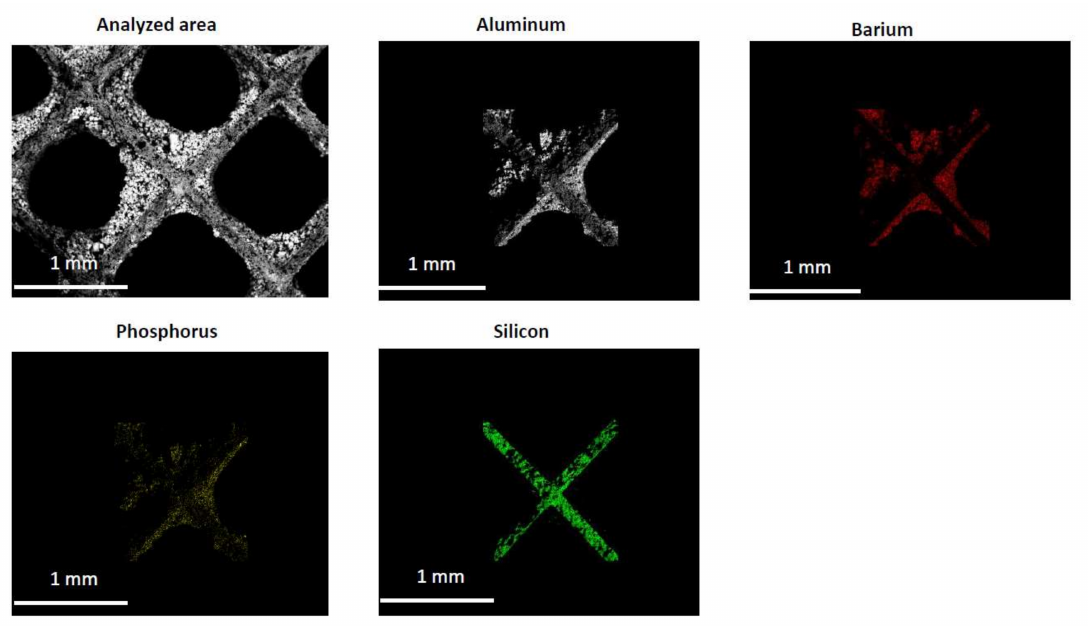
Figure 9. ESEM and EDX images from the cross-section 2 mm from the back of the Pt/Ba/Al 2 O 3 sample exposed to 50 vol.-ppm H 3 PO 4 for 34